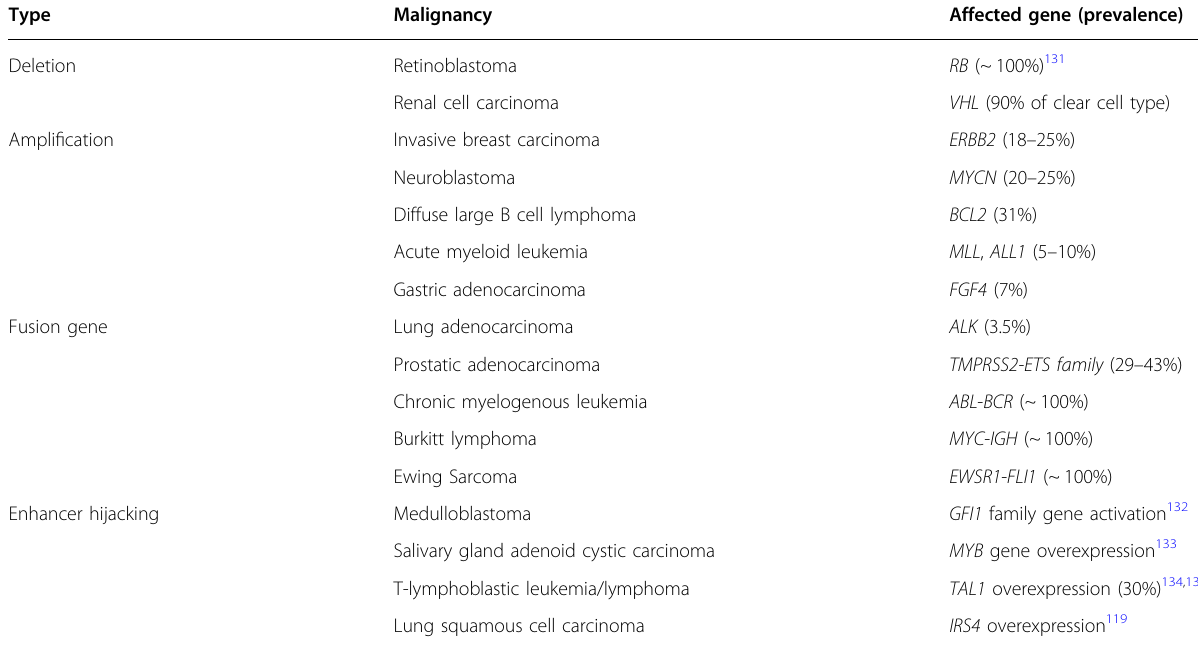
Table 1 Selected examples of genes altered by structural variation in cancers